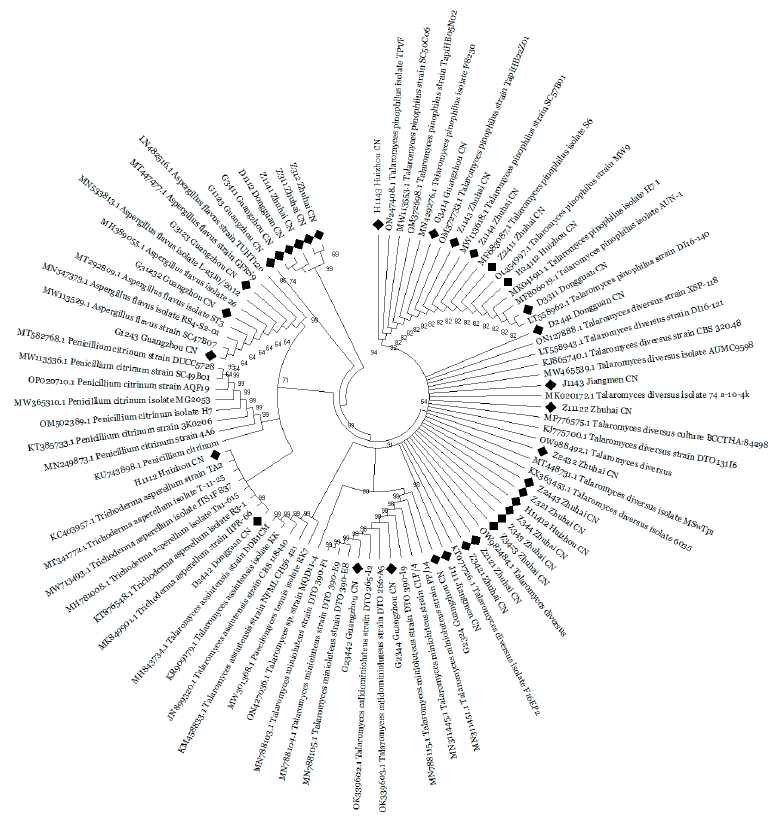
Figure 3. Phylogenetic analysis based on a combined dataset sequence of ITS, 18s, and 28s partial sequences of the characterized fungal isolates. Neighbor ‐ joining method was utilized to infer the evolutionary history, while the evolutionary distances were computed using maximum composite likelihood method. The optimal tree is shown. This analysis involved 92 nucleotide sequences and 273 positions in the final dataset. The fungal taxa used in this study are highlighted with black dots. Evolutionary analyses were conducted in MEGA11. Table 2. Fungal taxa characterized from different substrates collected from five cities of Guangdong Province of China. Isolate Number